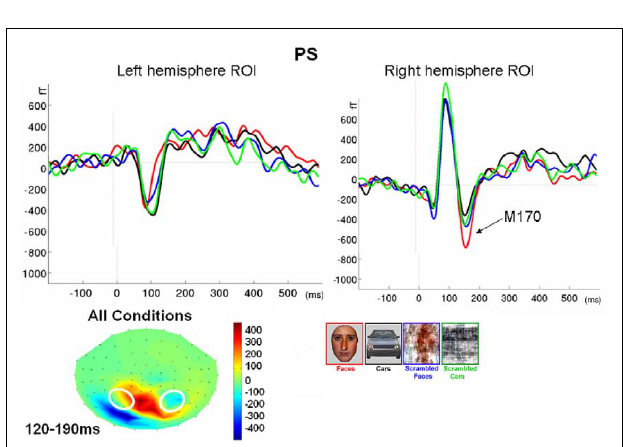
FIGURE 8 | Evolution of magnetic fields evoked by visual stimulation as recorded by 102 magnetometers for patient PS averaged across 10ms time windows around the M170 component in Experiment 1 (viewed from above, nasion upward; data are interpolated linearly